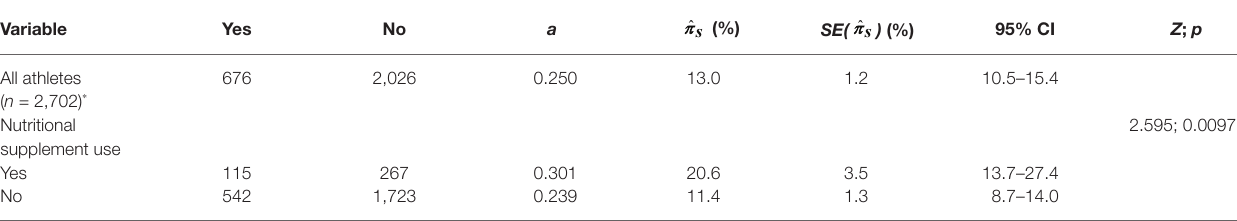
* Of the 2,987 athletes that filled in the questionnaire, 285 athletes provided no valid response on the RRT question resulting in a case number of 2,702 for the present table. ˆ s p , prevalence estimate for the use of doping substances; a, the proportion of total “yes” responses in the